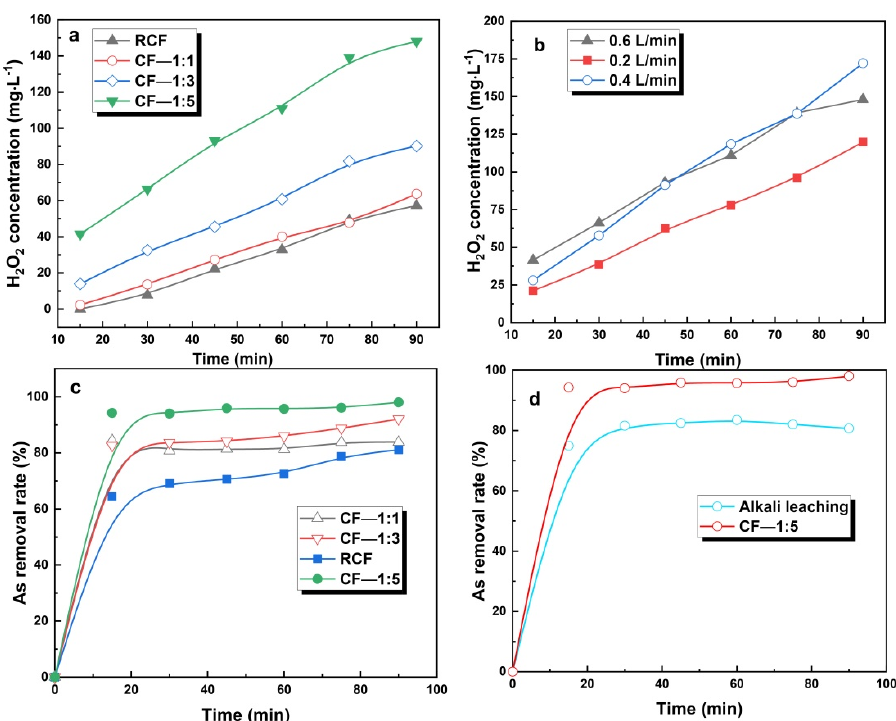
Figure 8. ( a ) Content of H 2 O 2 in situ generated by different electrodes, ( b ) the change of H 2 O 2 generated by CF—1:5 with different oxygen flow rate, ( c ) the change of arsenic removal rate from the ACRD by different electrodes, ( d ) and the difference between alkaline leaching and electrochemical advanced oxidation leaching.